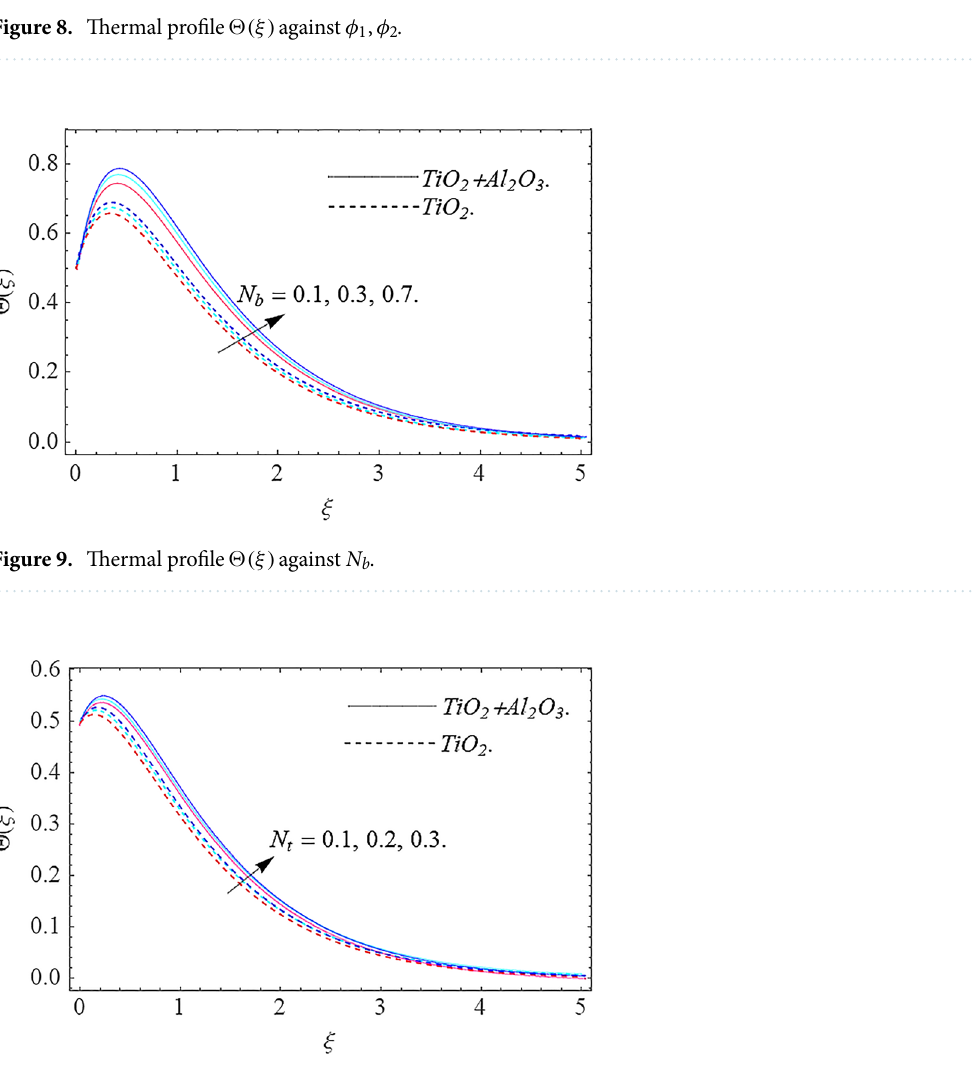
Figure 10. Thermal profile �(ξ) against N t